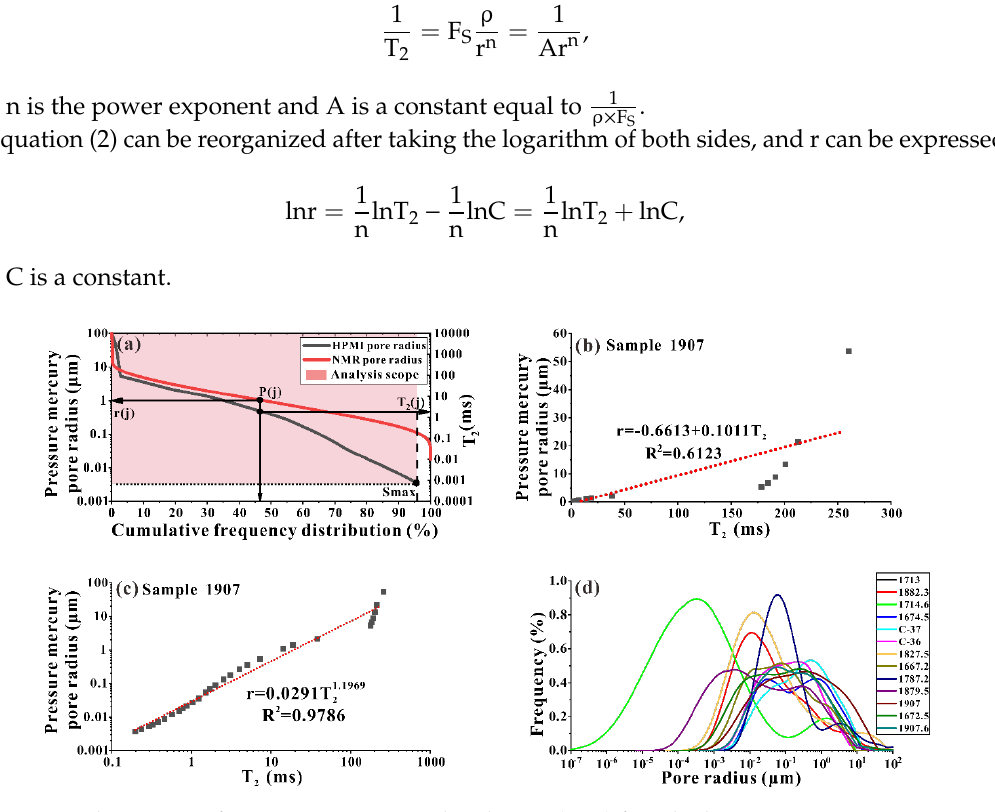
Figure 2. The process of integrating pore size distribution (PSD) from high-pressure mercury injection (HPMI) and nuclear magnetic resonance (NMR). ( a ) Cumulative pore volume fractions of HPMI and NMR; ( b ) linear regression results of the relationship between relaxation time (T 2 ) and pore radius (r); ( c ) power regression of T 2 and r; and ( d ) results of PSD derived by the combination of NMR and HPMI.